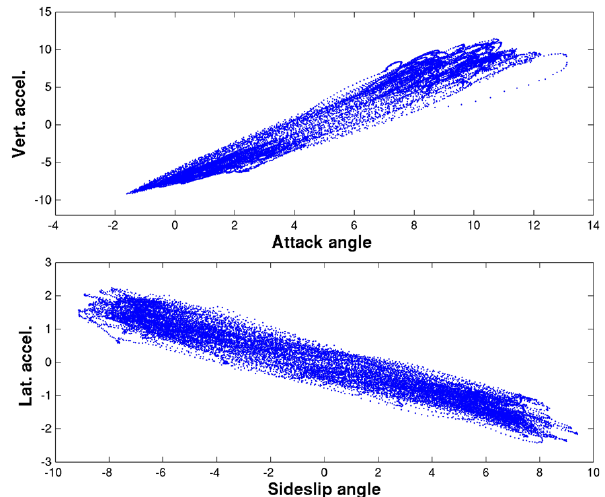
Fig. 8. Time series of (a) height difference (geometric-pressure) [m], (b) attack angle [deg], (c) sideslip angle [deg], and (d) pres- sure deviation from lever arm correction [Pa]. Time series is the concatenation of four 500s segments, the first two flown at 4600m, the second two at 7000m.